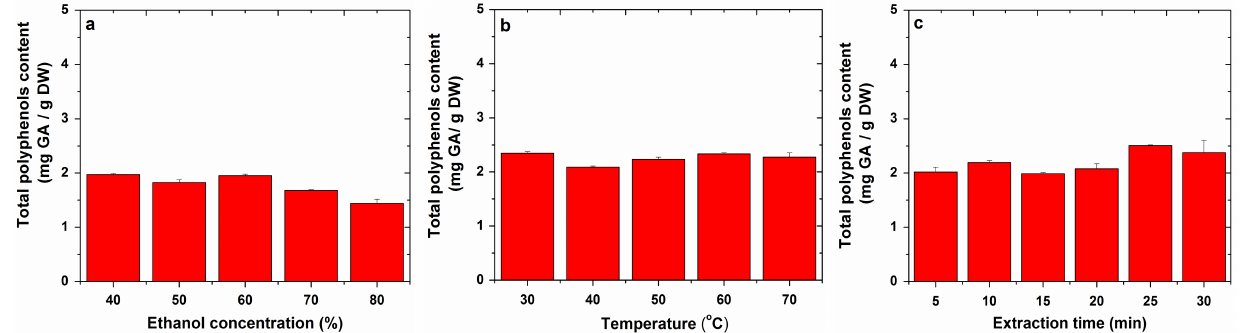
Figure 2. The effect of experimental parameters: ethanol concentration ( a ), temperature ( b ) and extraction time ( c ), on total phenolic content from apple extracts obtained by